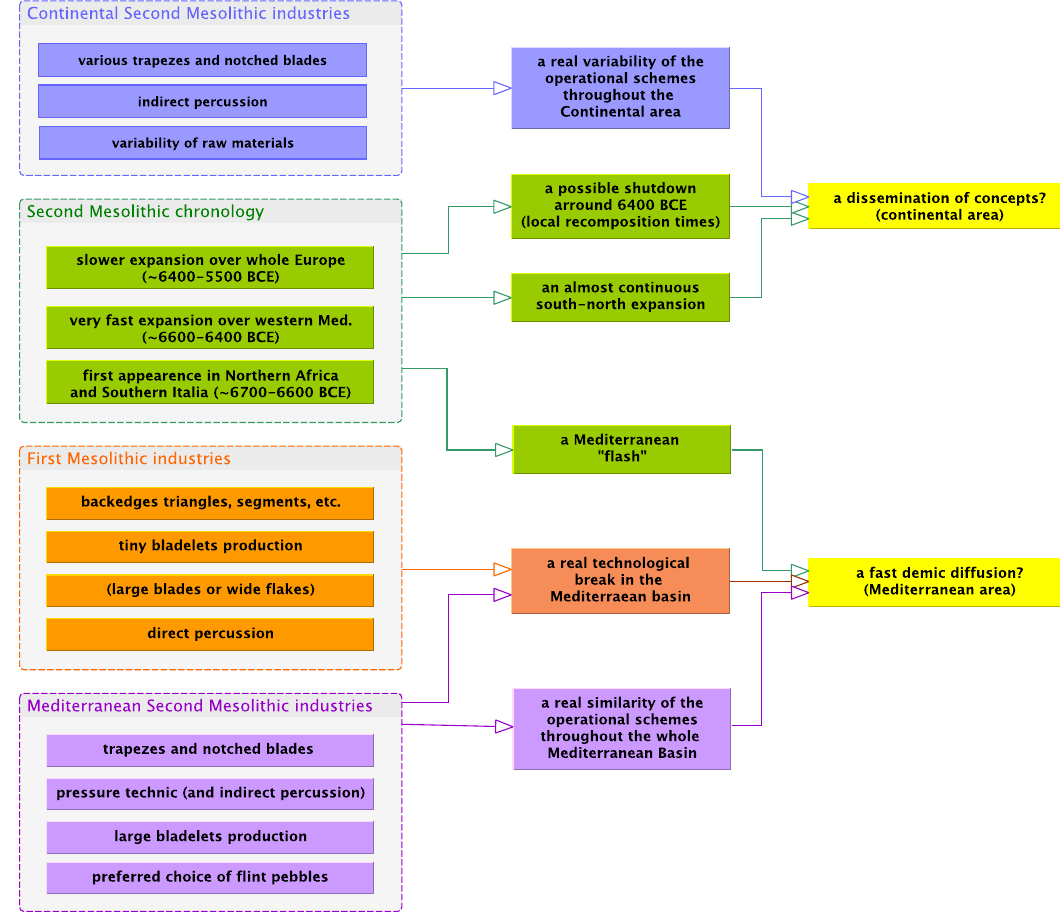
Figure 8: Logicist scheme of the interpretation of the appearance of the Second Mesolithic in the Western